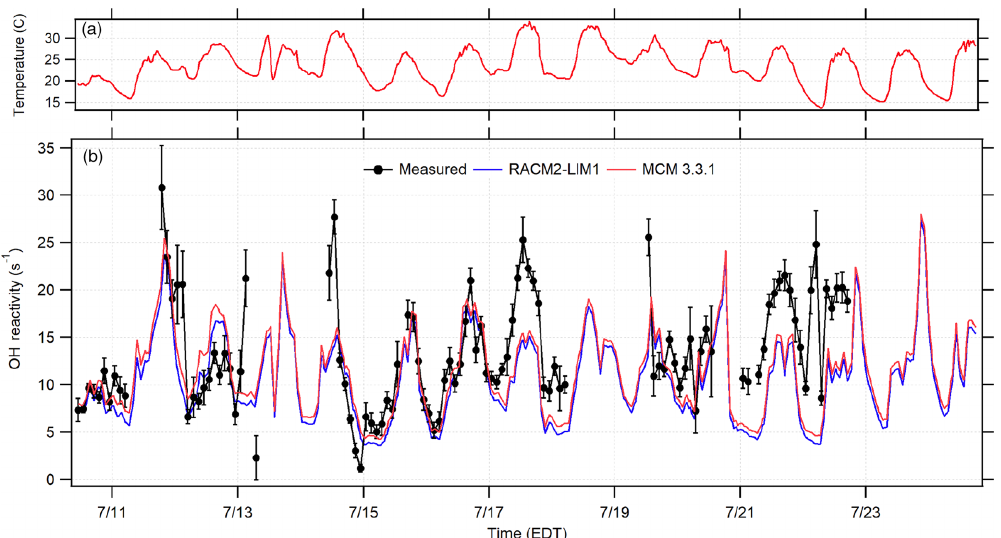
Figure 7. Time series of the 2h averaged OH reactivity measurements (black circles) in comparison to the calculated RACM2-LIM1 and MCM 3.3.1 OH reactivity based on measured OH sinks along with ambient temperature (a) . Error bars represent the standard error of the average